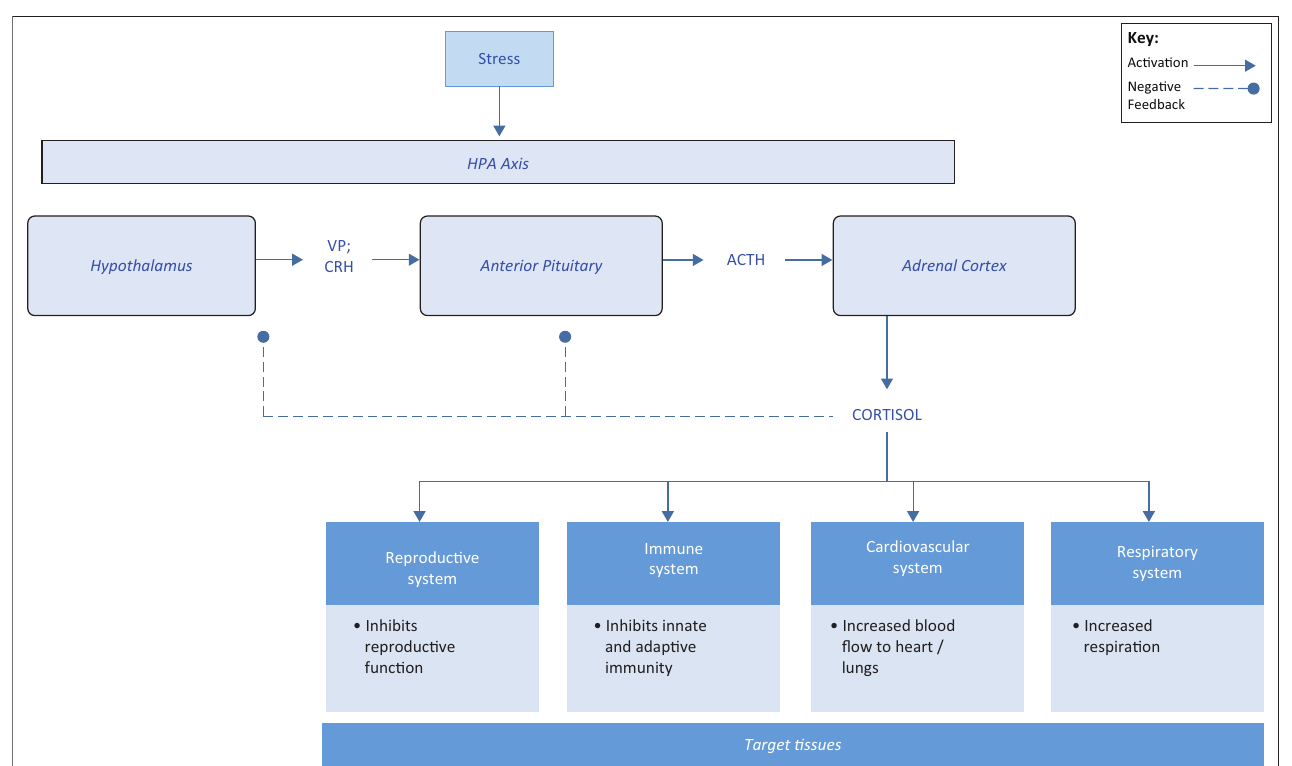
FIGURE 2: The response of the hypothalamo-pituitary-adrenocortical axis to